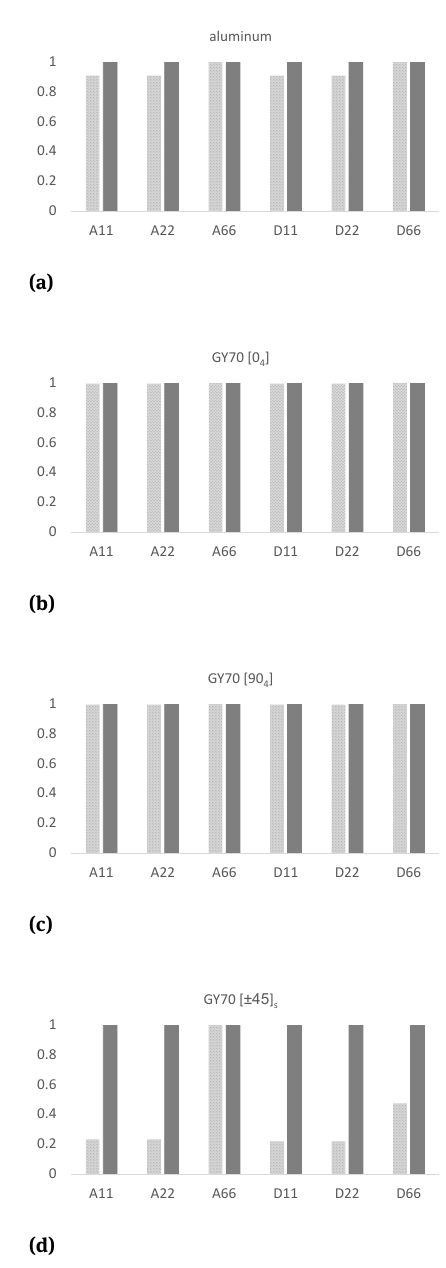
Figure 9: Constrained (darker gray) versus unconstrained (lighter gray) stiffness